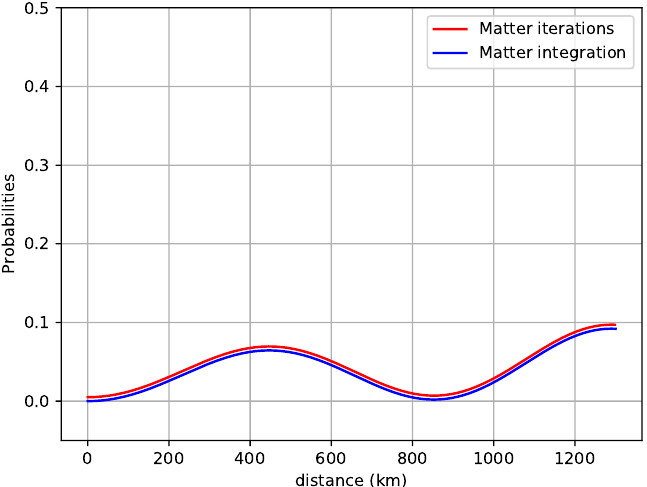
Figure 5. Comparison of the electron neutrino appearance probability, calculated with the iteration method described in the text, and the direct integration method for smoothly varying electron (matter) density (see text for details). The two curves are artificially separated by 0.005 for a better view. A muon neutrino beam of 0.8 GeV was used in the